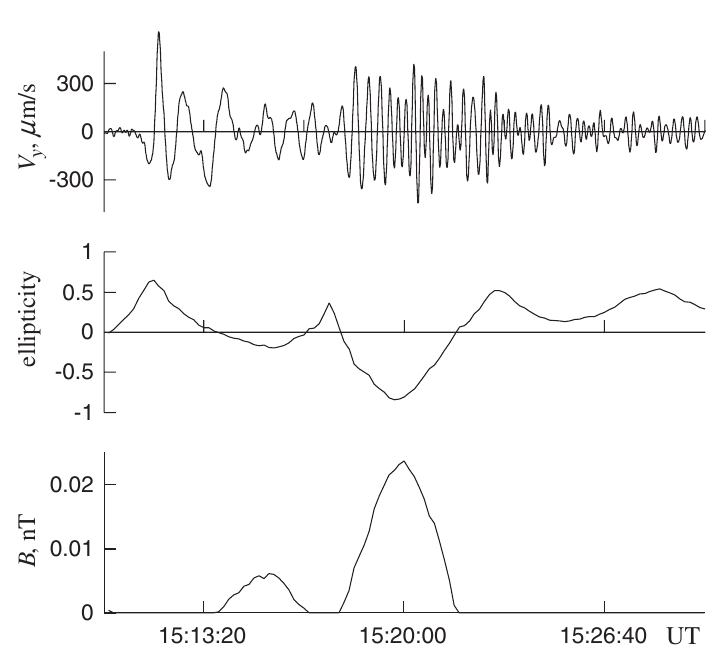
Fig. 4. Comparison of seismic oscillations V y ( top panel) with variations in the ellipticity of magnetic oscilla- tions ( middle panel) and the amplitude of magnetic oscillations with a left-hand circular polarization in the tan- gent plane ( bottom